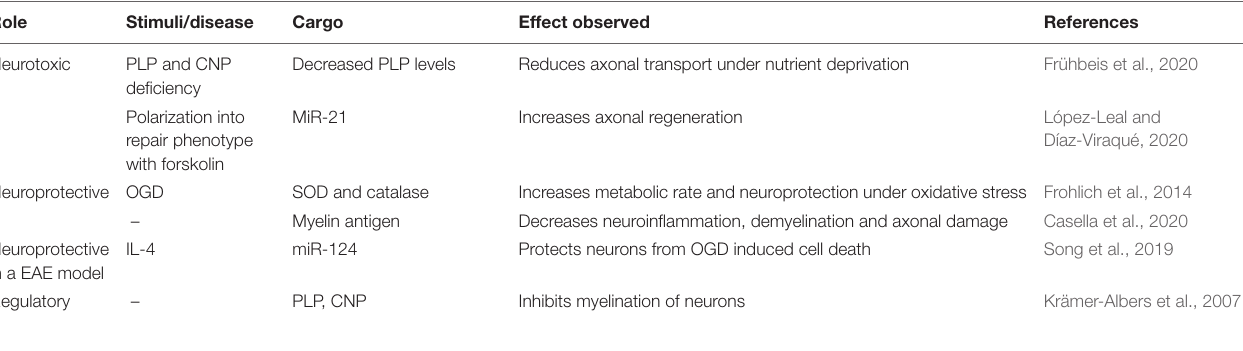
TABLE 3 | Summary of neuroprotective and neurotoxic effects of oligodendrocytes and Schwann cells-derived exosomes with identified